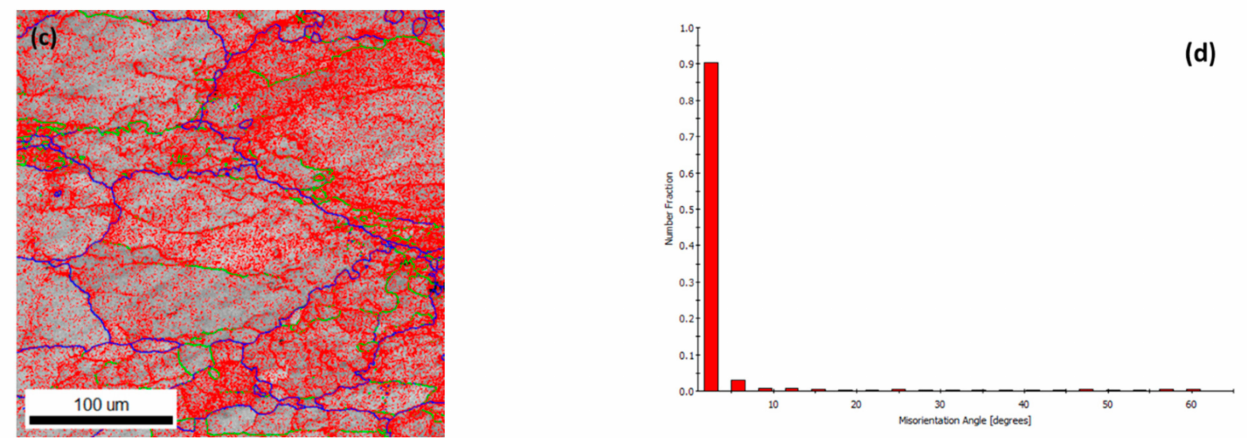
Figure 6. Grain Boundary maps for 900-90 joint ( a ) HAGB-LAGB map—S ( b ) Grain mis-orientation— SZ ( c ) HAGB-LAGB map—HAZ ( d ) Grain mis-orientation—HAZ.